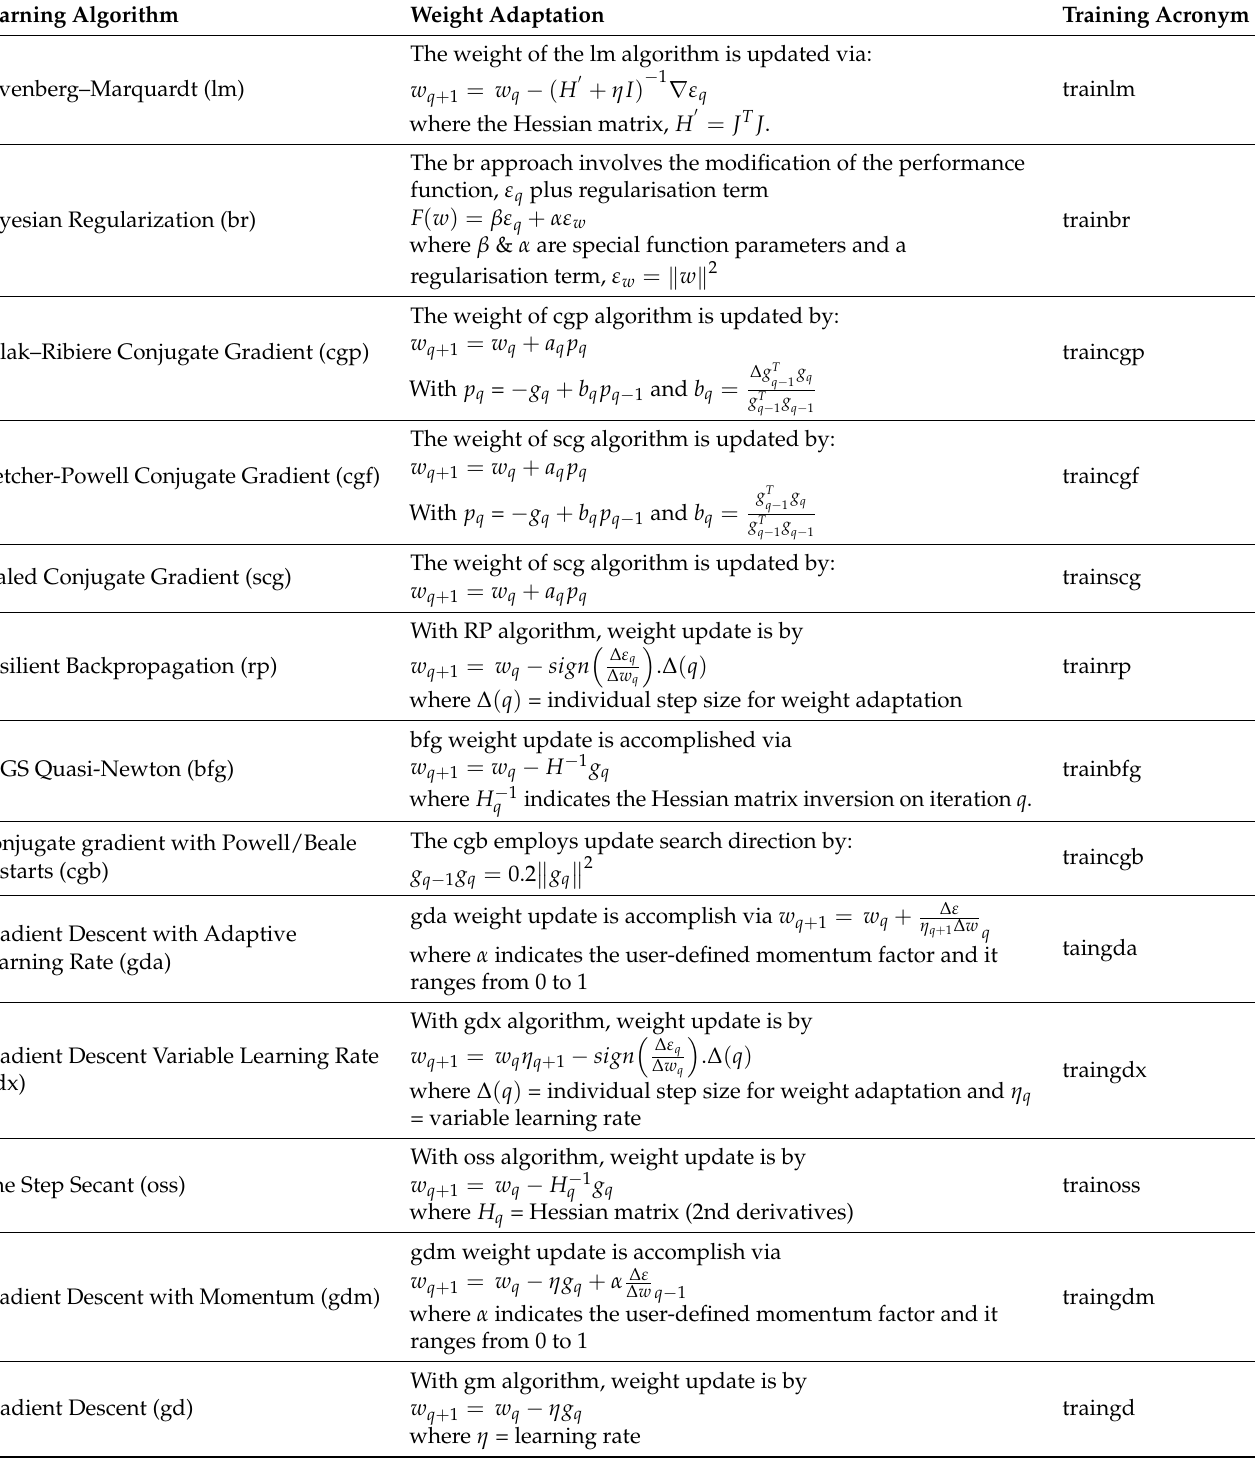
Table 2. Respective MLP Network Learning